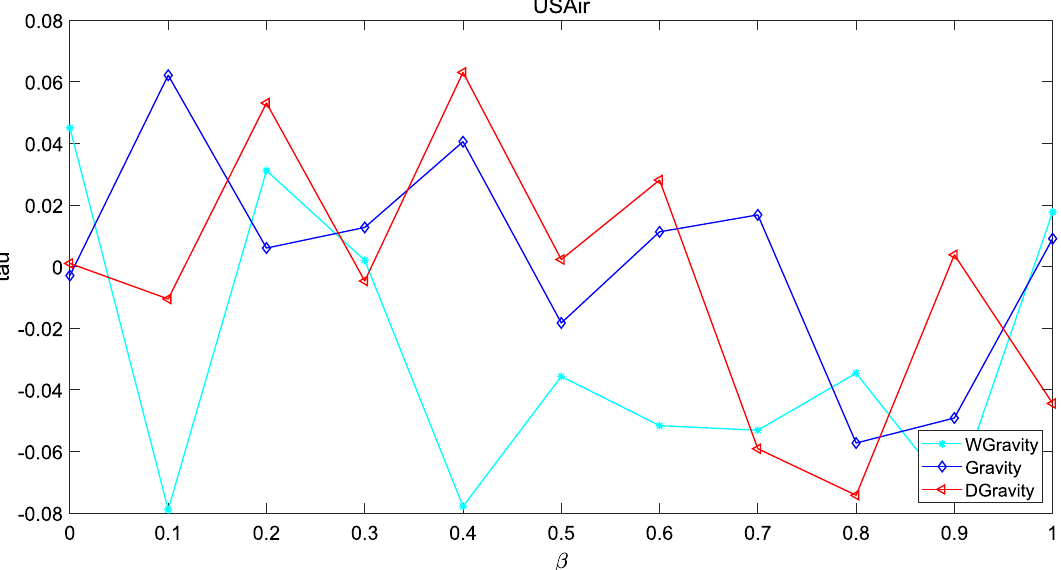
Figure 17. This figure describes the correlation between the methods based on gravity model and the standard sequence generated by SI in USAir. when β > 0.5, the tau of the new model is below 0 which means the number of negative pairs is larger than the number of positive